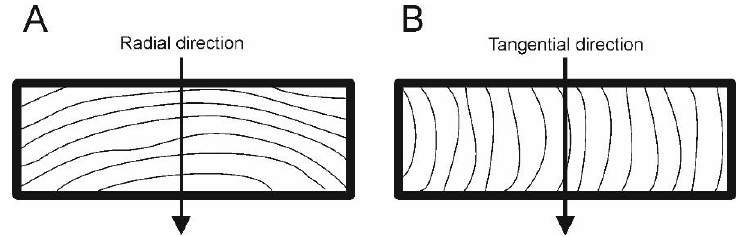
Figure 2. The direction of pressure of the plates in case of the radial ( A ) and tangential ( B ) samples.